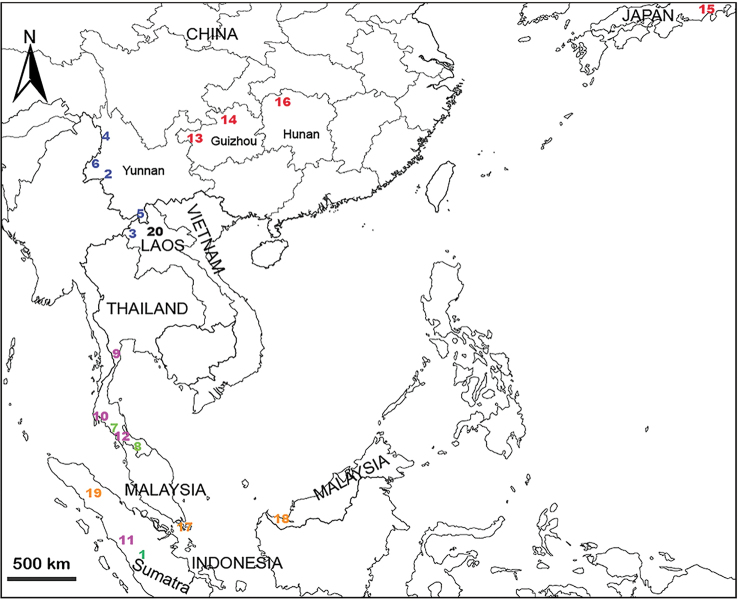
Distribution records of telemid species in East and Southeast Asia (except Pinelema). 1Apneumonella
jacobsoni2Mekonglema
bailang sp. nov. 3M.
kaorao sp. nov. 4M.
walayaku sp. nov. 5M.
xinpingi comb. nov. 6M.
yan sp. nov. 7Siamlema
changhai sp. nov. 8S.
suea sp. nov. 9Sundalema
acicularis comb. nov. 10S.
anguina comb. nov. 11S.
bonjol sp. nov. 12S.
khaorakkiat sp. nov. 13Telema
auricoma14T.
guihua15T.
nipponica16T.
wunderlichi17Telemofila
fabata comb. nov. 18T.
malaysiaensis comb. nov. 19T.
samosirensis20Zhuanlema
peteri sp. nov.